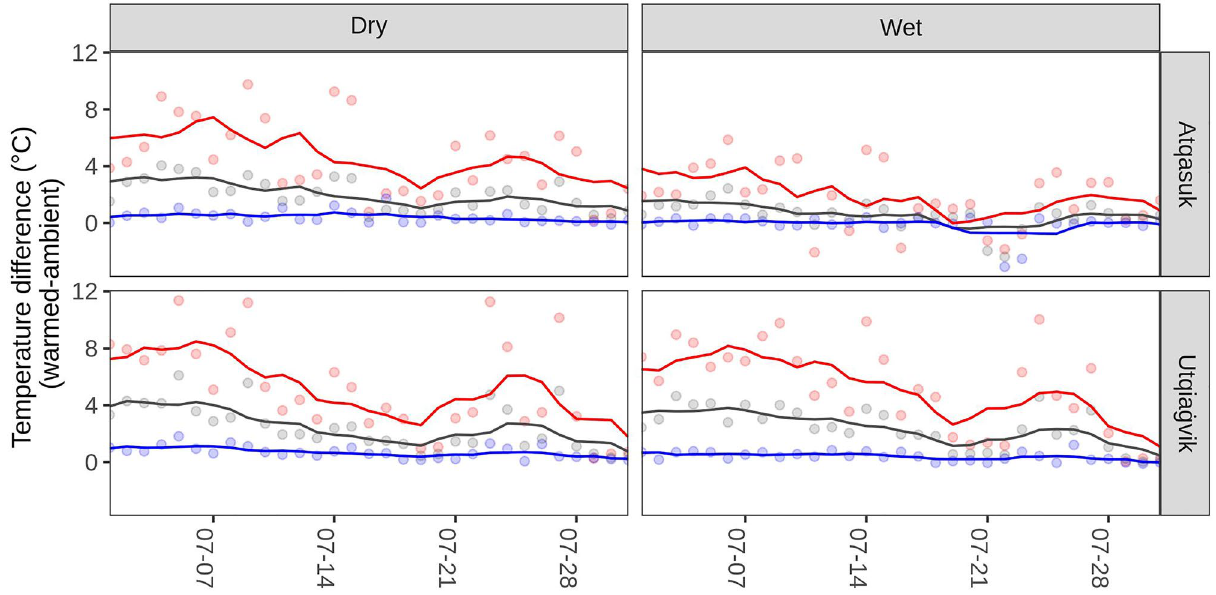
Figure 2. Daily variability of passive experimental warming. Points show the daily difference in minimum (blue), maximum (red) and mean (grey) temperatures in July of 2008 at each location; lines show the 7-day rolling average. Passive warming with open topped chambers varies based on weather conditions but is generally greatest when solar intensity is highest resulting in increased daily maximums.